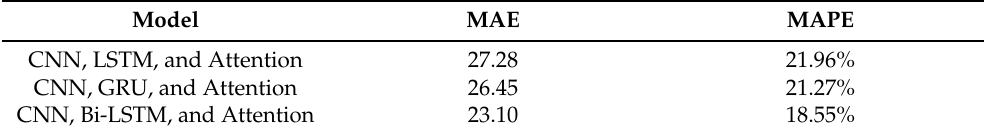
Table 7. Evaluation of the performance of different RNN models.